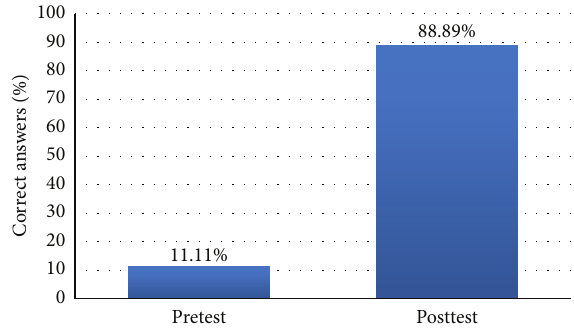
Figure 13: Percentage of correct answers to the question about the behavioral strategies used by lizards for regulating body tempera-